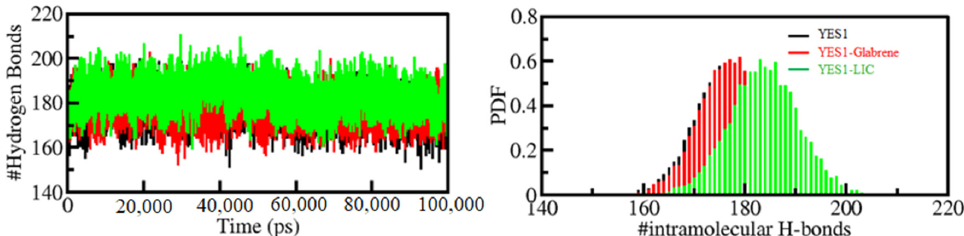
Figure 5. Hydrogen bond analysis. Time evolution of intramolecular H-bonds ( left panel ). The ( right panel) shows the PDF of the hydrogen bond distribution. # represents number.